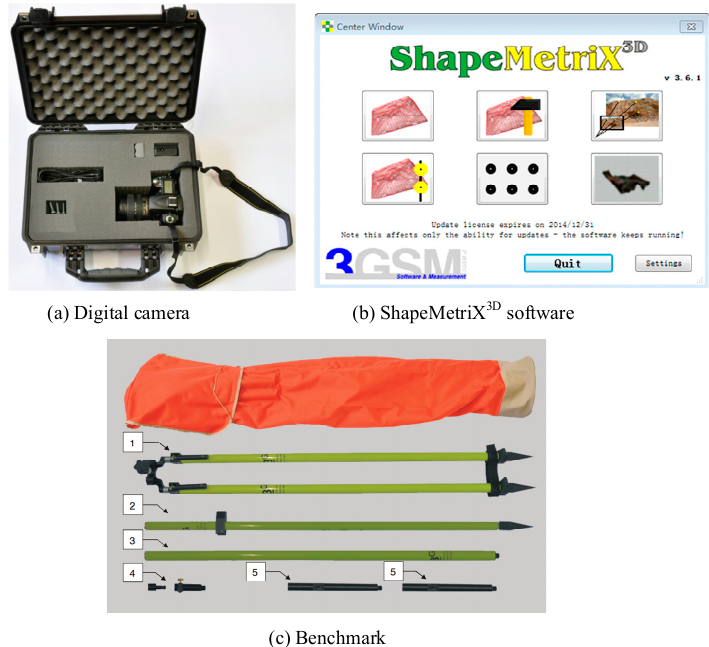
Figure 2. Composition and principle of the ShapeMetriX 3D system. Research steps 1–5 are the process of data collection based on the equipment.